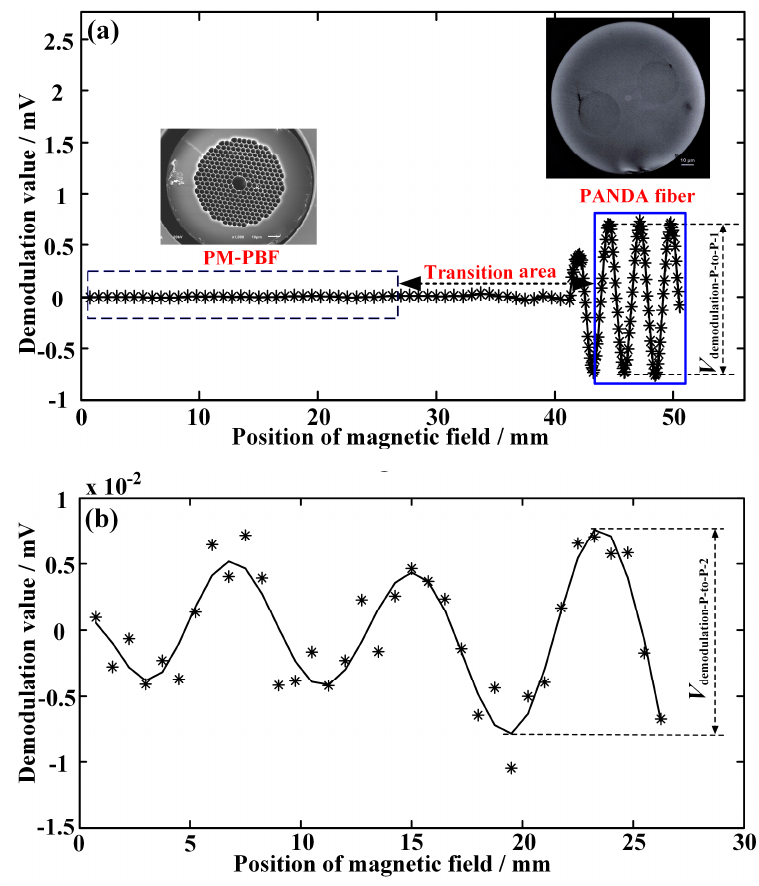
Figure 2. Test results of the Verdet constants of the PM-PBF and conventional PANDA fiber. ( a ) V demodulation sinusoidally oscillates as the position (P m ) of the magnetic field uniformly scans from the right to the left of the fusion splicing point P 2 in Figure 1. ( b ) Enlarged image of the area within the dashed-line rectangle in ( a ).